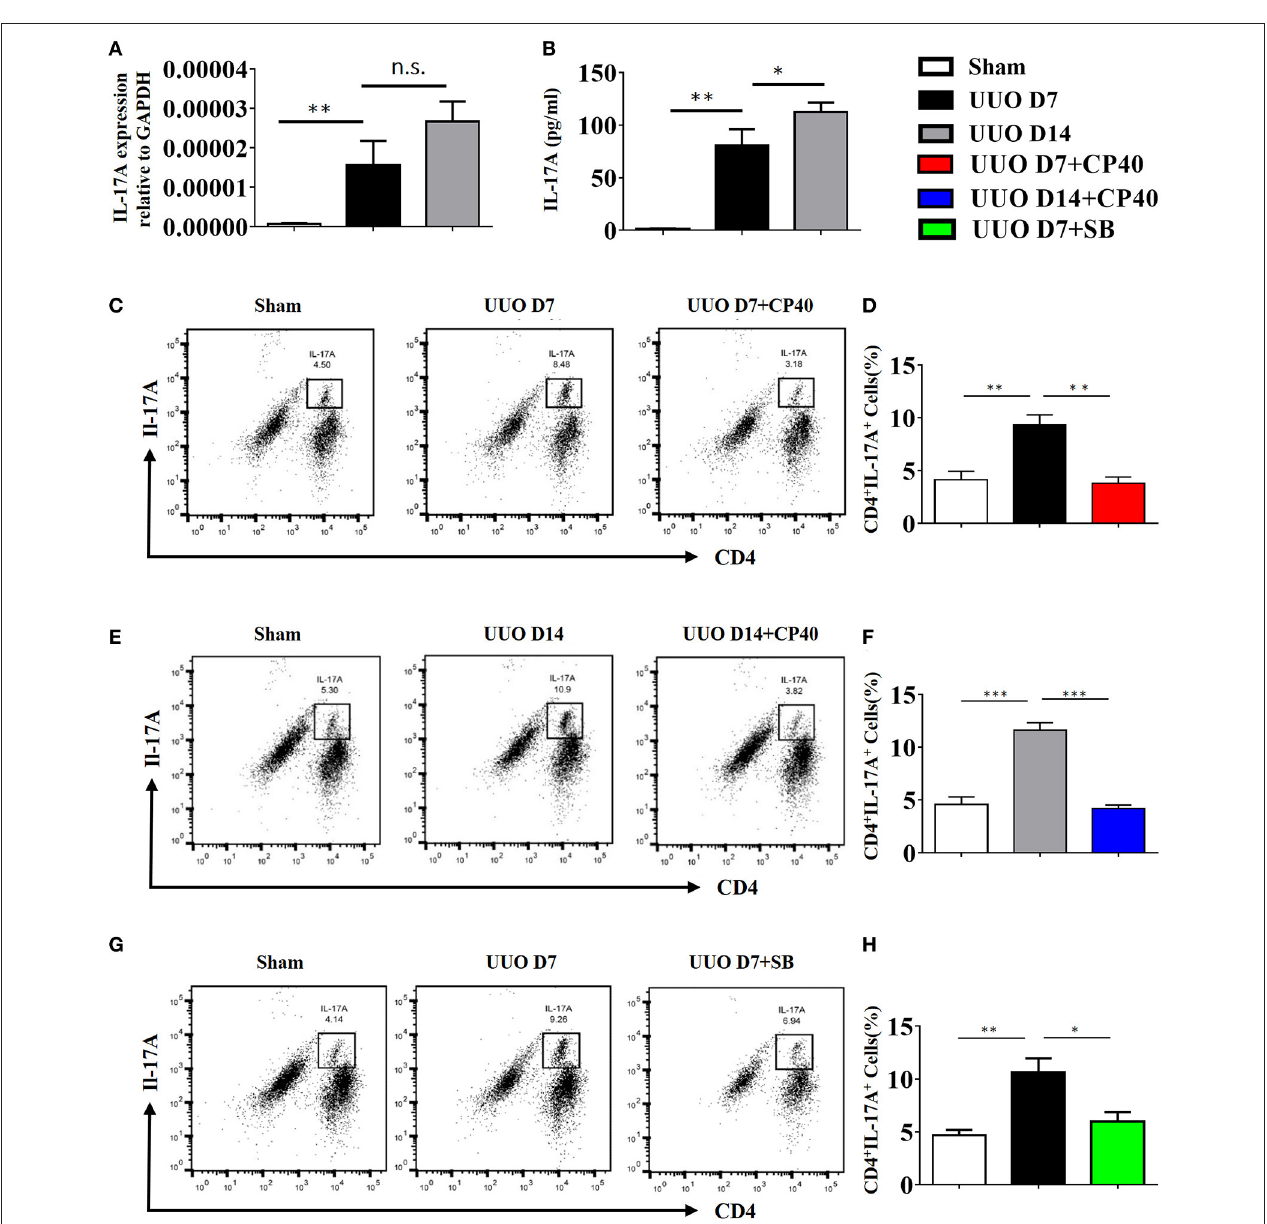
FIGURE 7 | The expression of IL-17A is induced in UUO mice. Mice were subjected to unilateral ureteral obstruction (UUO) by left ureteral ligation for 7 and 14 days ( n = 6 per group). (A) IL-17A mRNA in whole kidneys measured by real-time PCR; ** P < 0.01 vs. sham operation; n = 6. (B) Production of IL-17A in obstructed kidneys was determined by CBA and was normalized to total protein content for each sample; ** P < 0.01, * P < 0.05 vs. sham operation; n = 6. Flow cytometric analysis (C,E,G) and quantification (D,F,H) of kidney cell suspensions from the obstructed kidneys injected with or without Cp40/SB290157 during the time course of UUO; n = 6. Cells were stimulated in vitro with PMA/Ionomycin/Golgi-plug for 4h. Specific staining of cell markers (anti-CD4) and intracellular staining for IL-17A were performed. Plots are gated for live CD4 + IL-17A + lymphocytes; numbers indicate events in the quadrants as percentages of all gated events. The error bars represent the SEM. * P < 0.05; ** P < 0.01; *** P < 0.001. The data were pooled from three independent experiments.